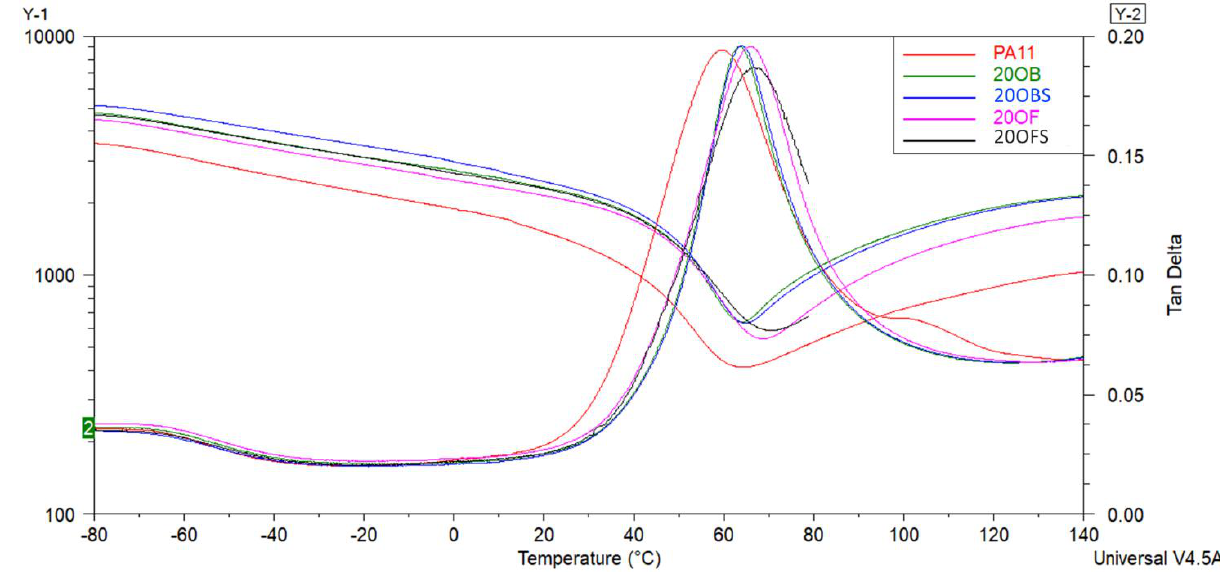
Figure 17. The storage modulus and tan δ curves of unmodified PA11 and composites; samples with 20% of diatoms. Table 6. Summary of the determined values of the glass transition temperature from tan δ curves and storage modulus E’ curves.